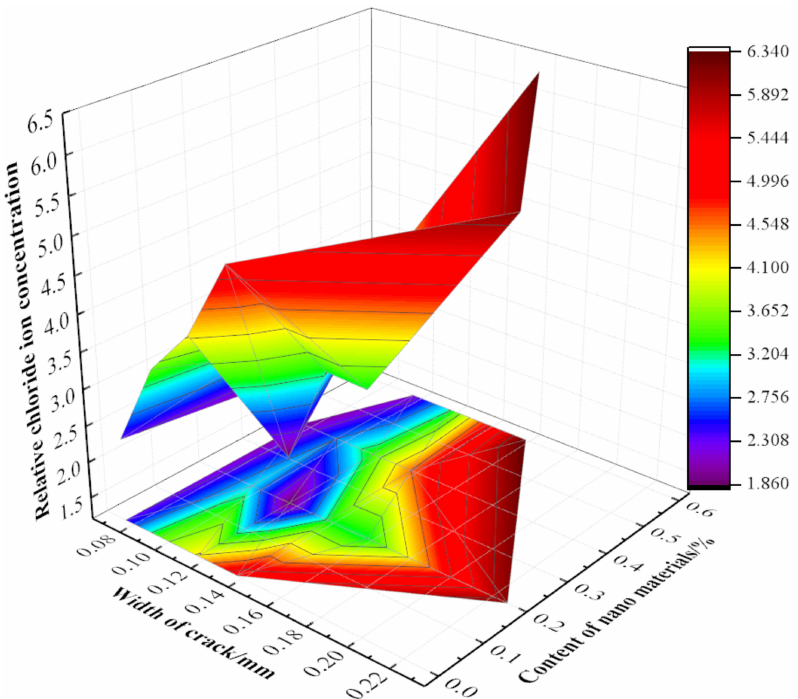
Figure 15. Distribution of relative chloride ion concentrations with crack width and nano-material